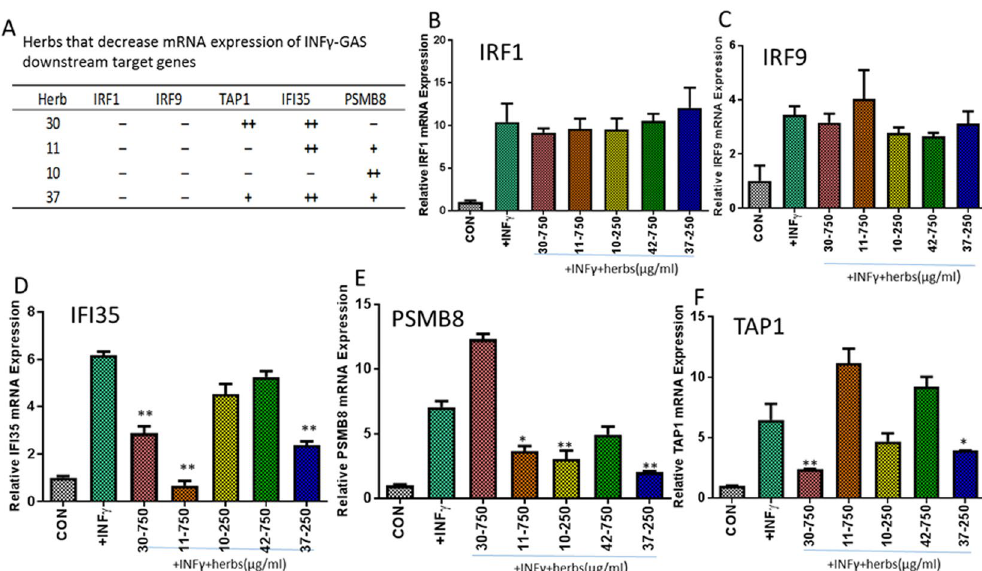
Figure 4. Impact of selected herbs on different INF- γ -GAS downstream gene expression. ( A ) Table of herbs inhibited INF γ induced mRNA expression of IRF1, IRF9, TAP1, PSMB8 and IFI35. ( B – F ) Quantitative real time PCR for mRNA expression of GAS garget gene IRF1, IRF9, IFI35, PSMB8 and TAP1. Each bar represents a mean of three different experiments (triplicate samples of each). Compare with + INF γ group, + , * p < 0.05; ++ , ** p < 0.01; − : no